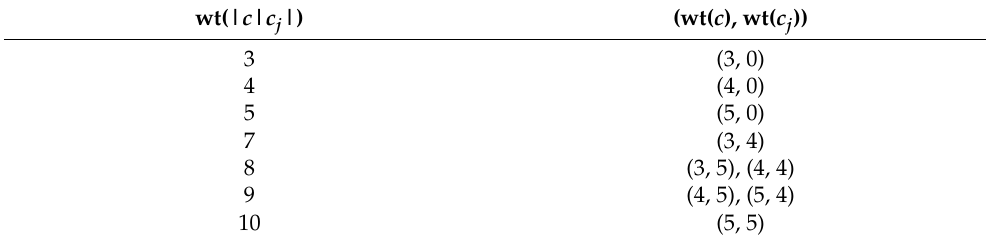
| ) at the destination in ascending order. j